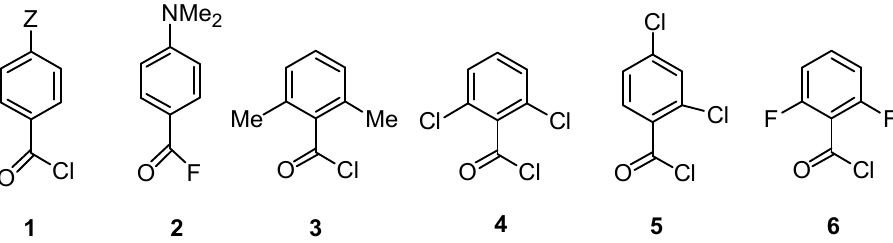
Figure 1. Halides ( 1 – 7 ) are named as follows: ( 1 ) p -Z-substituted benzoyl